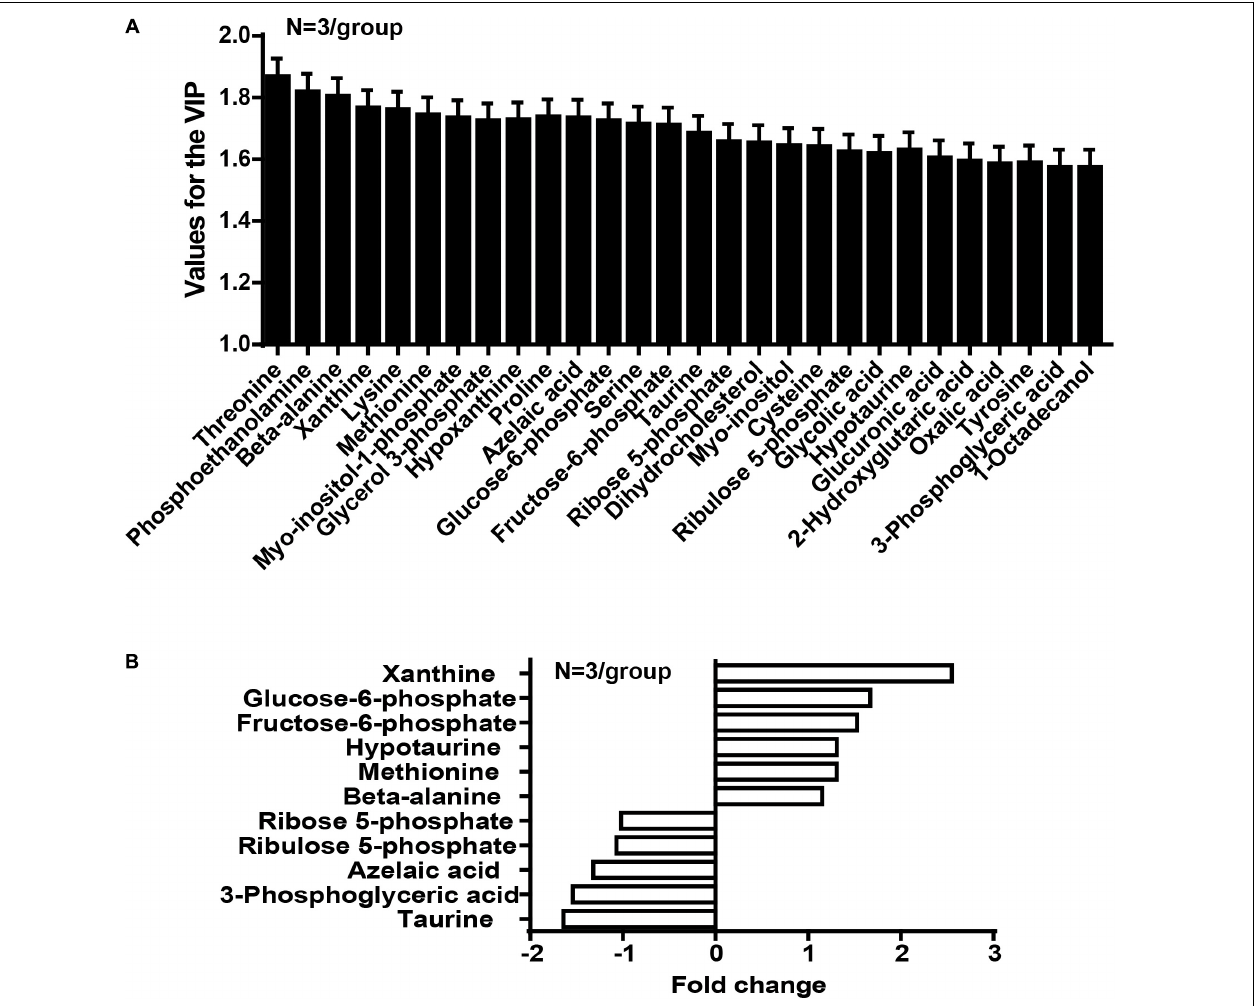
FIGURE 2 | The concentration of taurine is diminished whereas the concentration of hypotaurine is augmented in CRC tissues ( N = 3/group). (A) Values for the VIP of 28 characteristics are depicted. Each column displays one feature of the PLS-DA model (Figure 1) . Error bars represent the SEM. (B) Different levels of compounds between cancer and normal groups (2-tailed t test, P < 0.05). The y-axis represents the various compounds, and the x-axis represents fold-change in metabolite